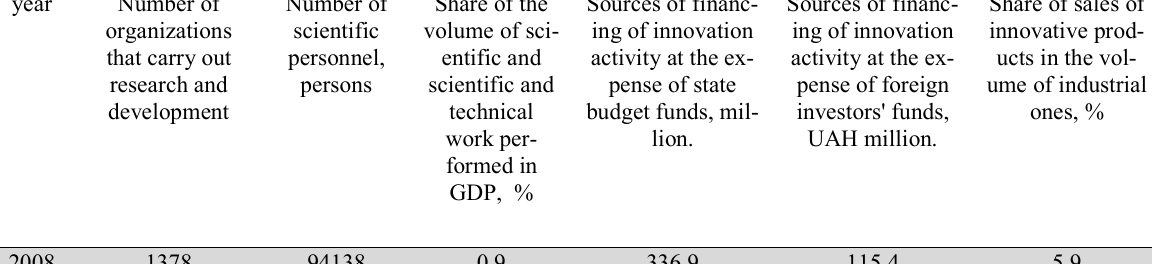
Science, technology and innovation in